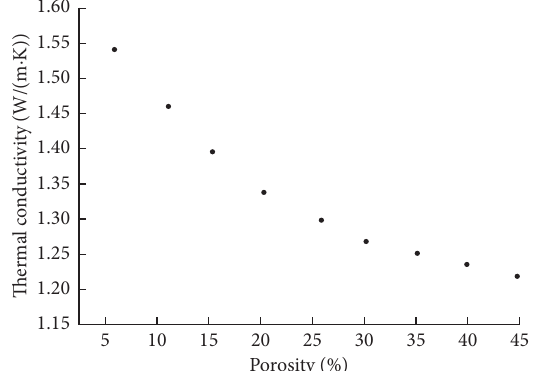
Figure 11: Thermal conductivity change with